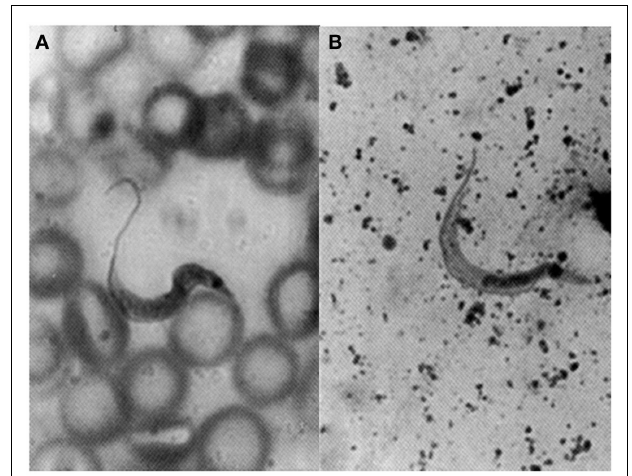
FIGURE 3 | Flagellate stages of Trypanosoma cruzi : (A) stout bloodstream trypomastigote from naturally infected Rattus rattus (Giemsa, 1400 × ); (B) metacyclic trypomastigote from feces of Rhodnius prolixus used for xenodiagnosis of naturally infected R. rattus (Giemsa, 1400 × ).